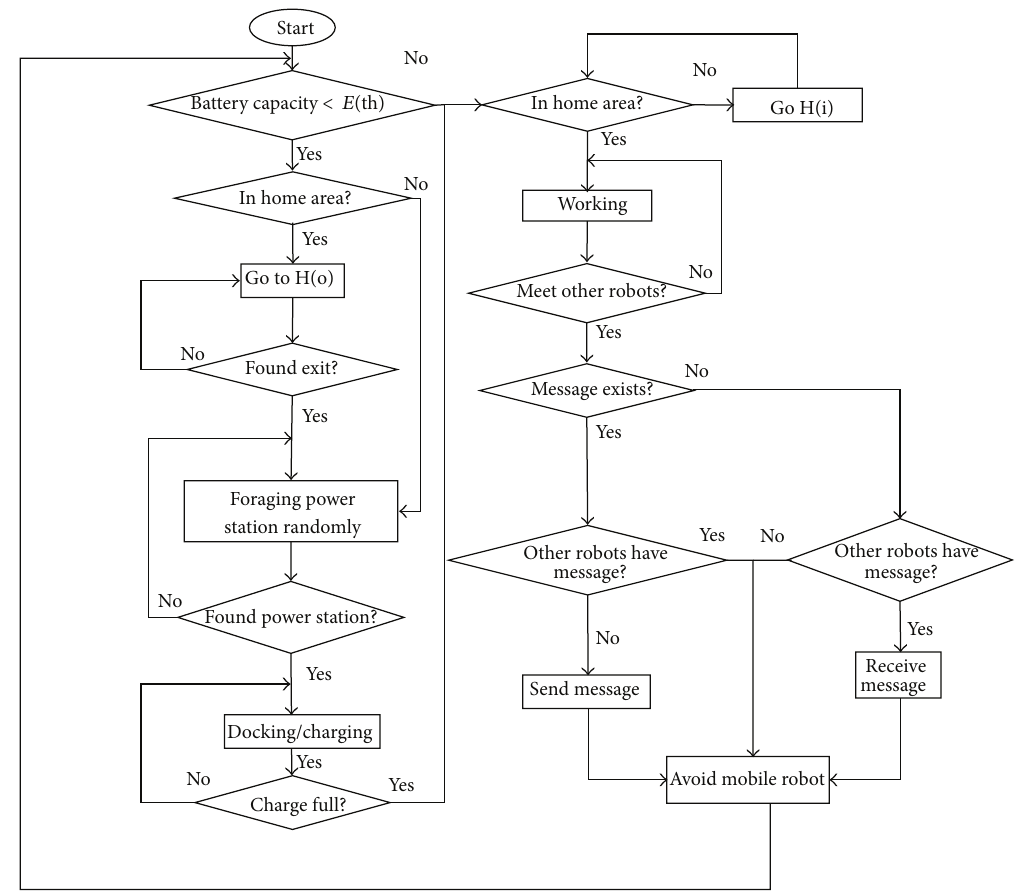
Figure 7: Algorithm of mobile robots behavior inspired by honeybees system.